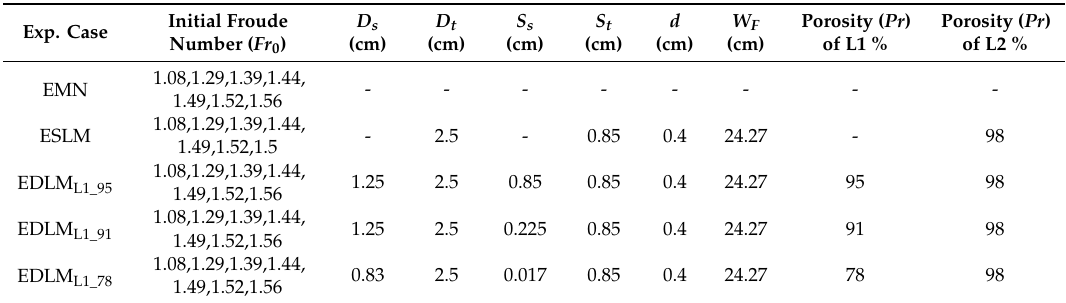
Table 1. Summary of the experimental conditions (meaning of symbols and definitions appear in the Figure 1 and in text of the Sections 2.1.1 and